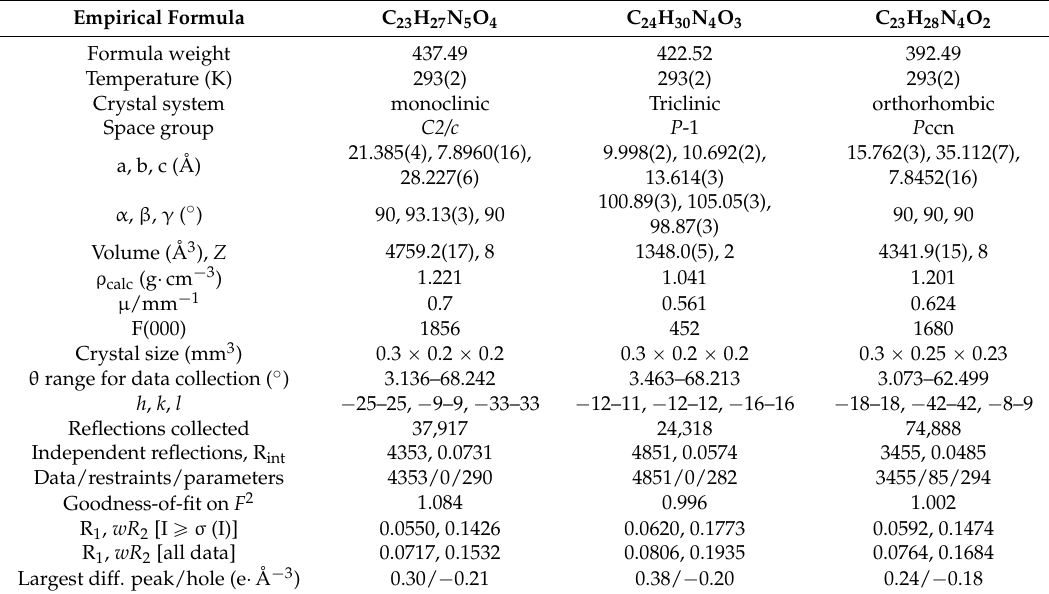
Figure 2. Crystallographic structure of compound 1 . Displacement ellipsoids are drawn at the 30% probability level, and intramolecular hydrogen bonds are presented in dashed lines. Table 1. Crystal data and structural refinement of compound 1 , 2 and 3